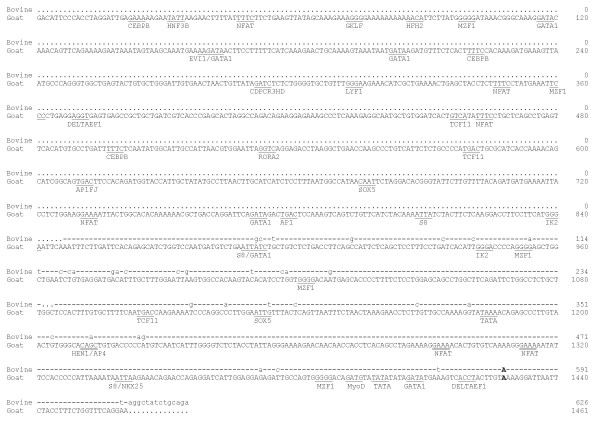
Sequence comparison of the proximal 5' -flanking regions of goat and bovine uromodulin genes. Identical nucleotides are indicated dashed. The putative transcriptional start site of the goat promoter (nt 1428) is in bold, deducted from the known bovine start site (nt 591, bold). TATA, CCAAT boxes and other potential binding sites of transcription factors are underlined. The nucleotide sequences of the goat uromodulin gene promoter and the goat uromodulin gene partial 3' end are available in the GenBank Database under the accession numbers AY702660 and AY702661, respectively.